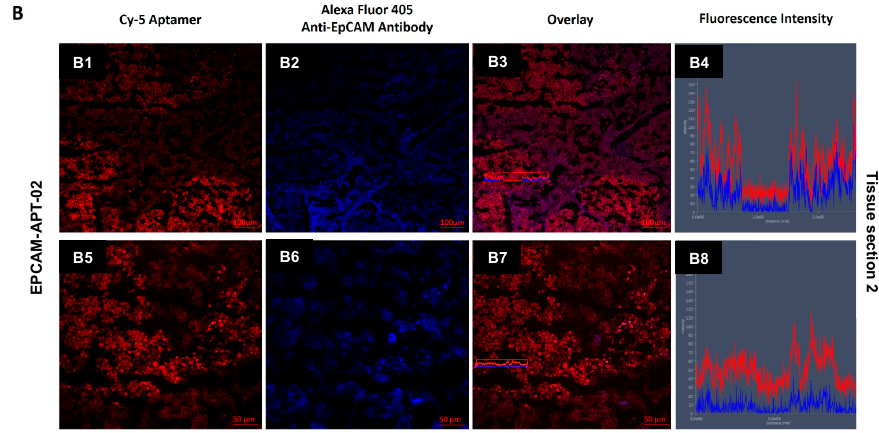
Figure 5. Co-staining aptamers and antibodies. Confocal microscopy of different regions of two squamous LC tissue sections stained with Alexa-Fluor 405-labeled anti-EpCAM antibodies and Cy-